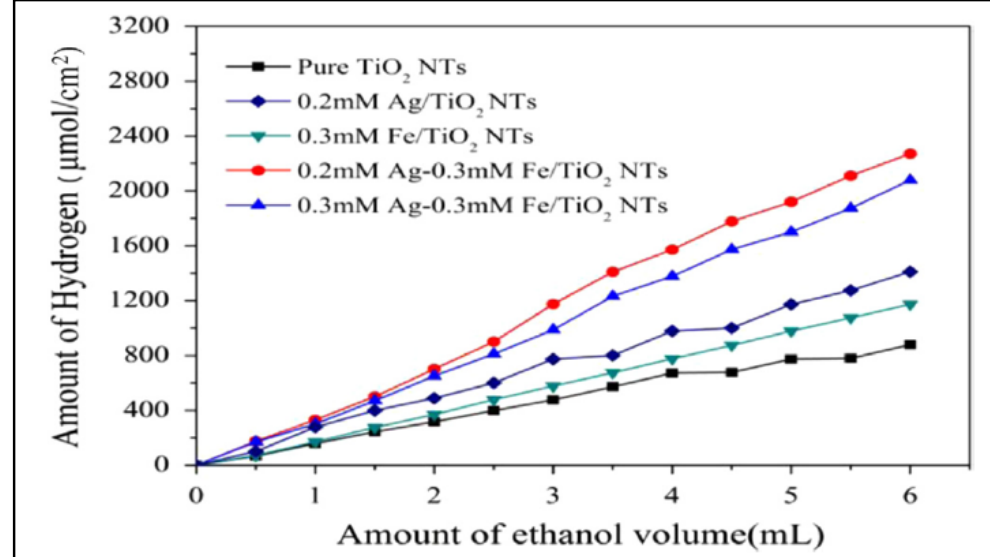
Figure 25. Hydrogen production by water splitting over TiO 2 catalysts. Reproduced with permission from reference [139].